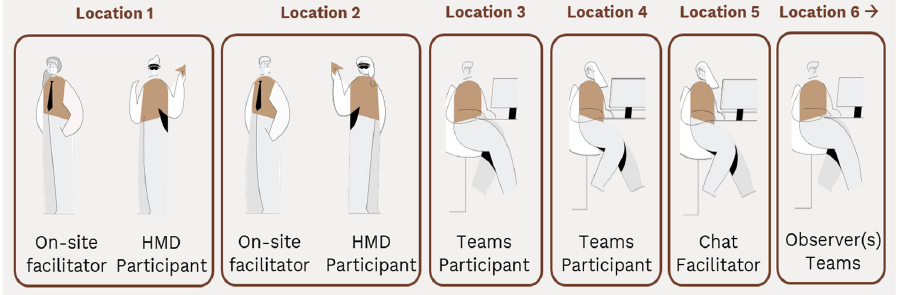
Figure 16. Test setup of Case 5.